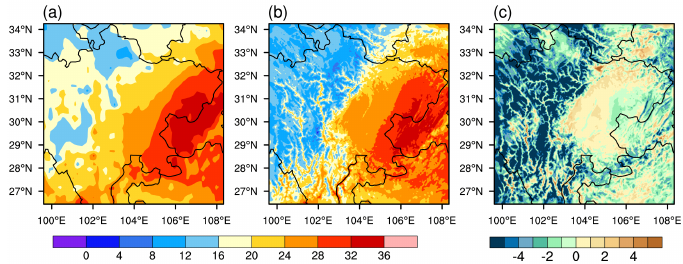
Figure A4. Same as Figure A3, but for the period of 00:00 UTC to 11:00